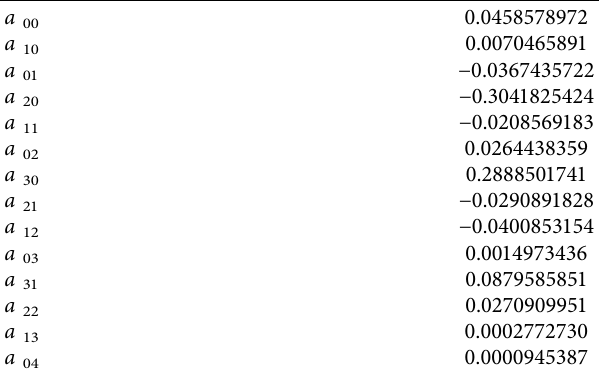
Figure 6: The variation in D (a) and difference between the υ 1 peak positions of CH 4 at elevated pressure ( υ p ) and near-zero pressure ( υ 0 ); bands in the Fermi diad of CO 2 Table 1: The fitting parameters for equation (5).